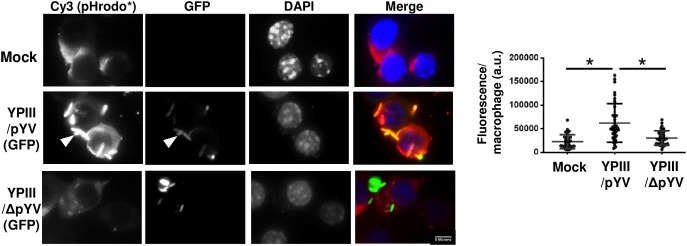
YACs are stably confined macrophage surface structures.RAW macrophages were infected for 60 minutes with GFP-expressing wild-type (pYV) or plasmid-cured (pΔYV) Y. pseudotuberculosis. pHrodo was then added to the infected cells for 40 minutes and were then analyzed as in Fig 3 and what is presented is representative of multiple experiments. The arrows in the middle row images indicates a YPIII/pYV bacterium that is intensely positive for pHrodo*. Plotted to the right is the corresponding fluorescence of individual macrophage-associated bacteria. (N >40 each condition; * P < 0.05 using student t-test)